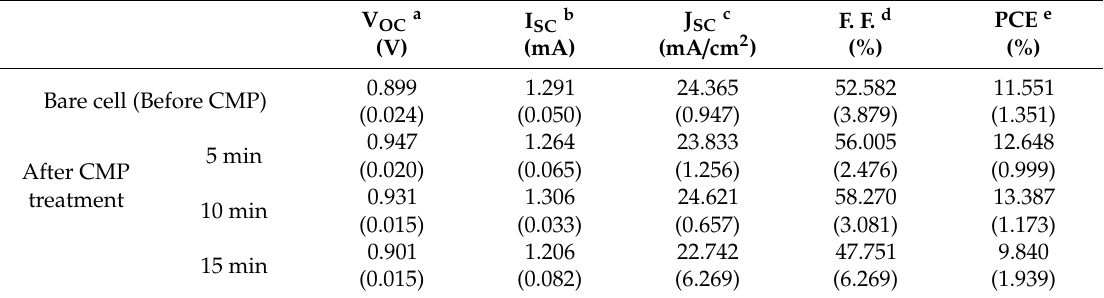
a. Open-circuit voltage, b. short-circuit current, c. short-circuit current density, d. fill factor, and e. power conversion e ffi ciency. ( ) = (Standard Deviation).